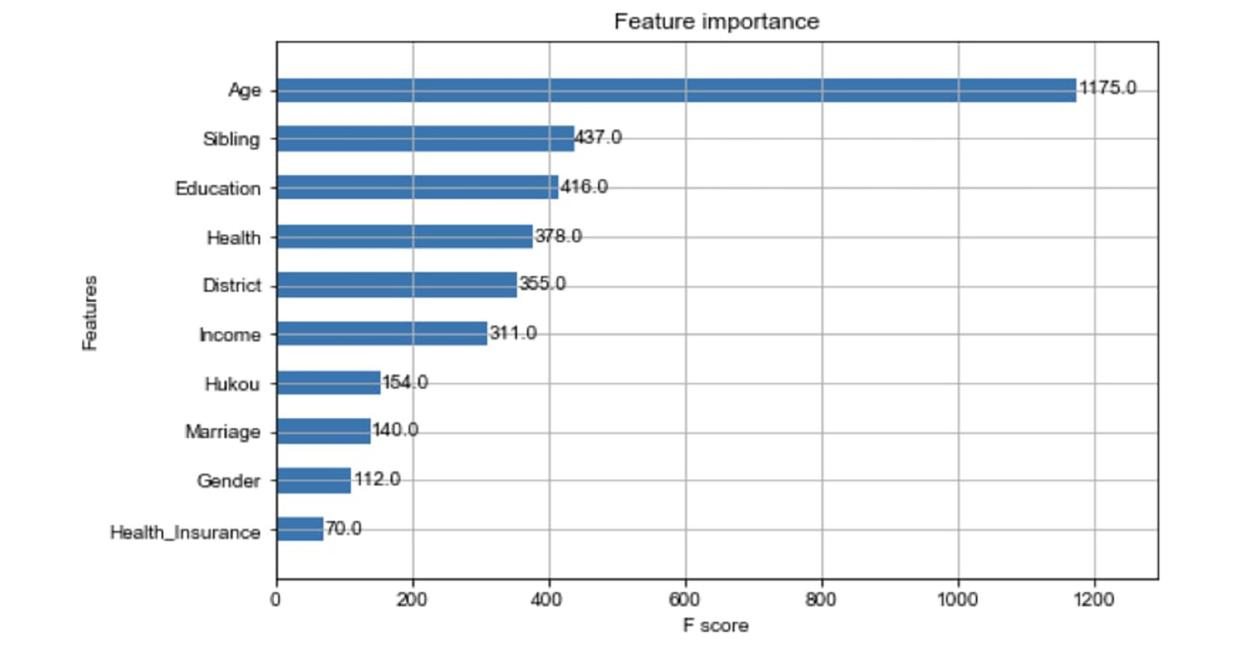
FIGURE 4 | Importance of variables in XG-boost